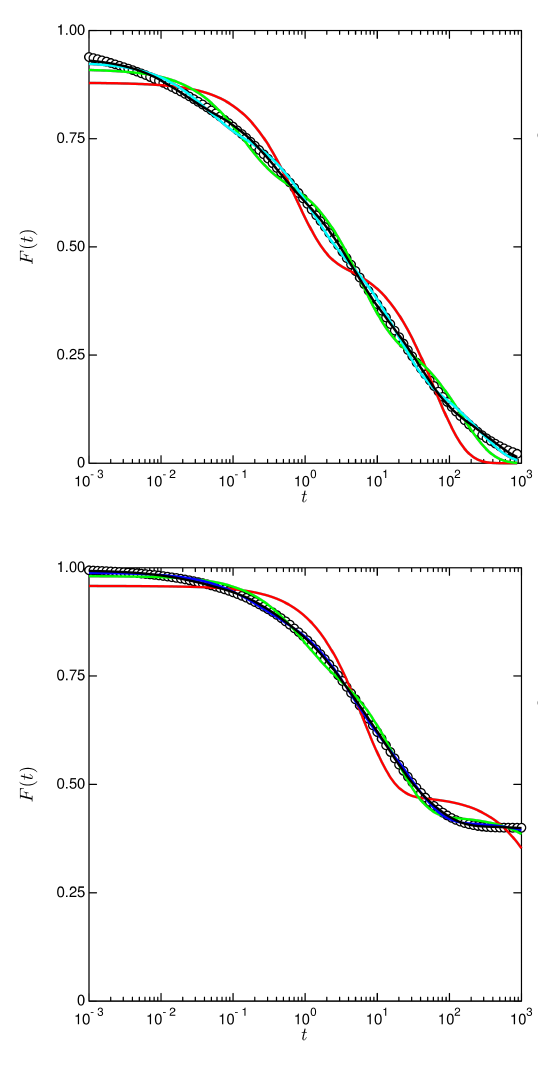
Figure 4. Example sequence of n-exp fits for increasing accu- racy requirements (colored lines) as obtained by the automatism used in the software implementation of the dynamic RPA pro- cedure [1]. The text functions (symbols) were: exp( − 0 . 3 t ) and 0 . 6 exp( − 0 . 5 t ) + 0 . 4. The black lines represent the final result obtained with 5 resp. 6 simple